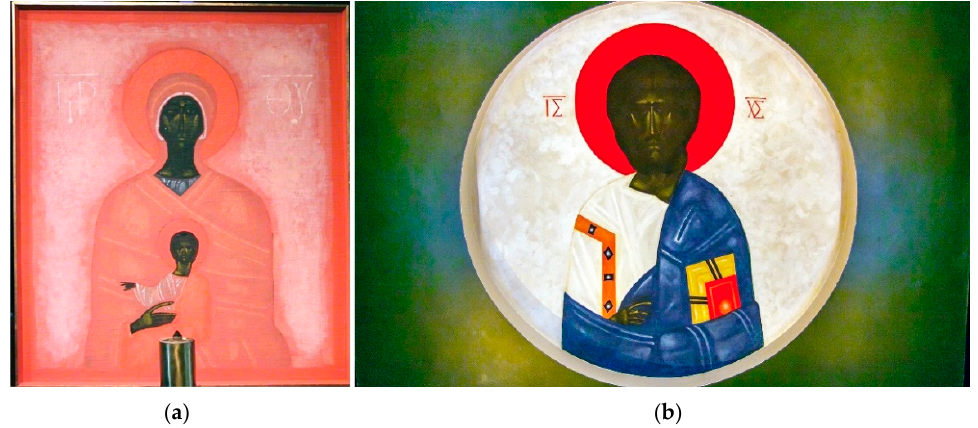
Figure 16. Jerzy Nowosielski, icons in the Church in Bia ł y Bór: ( a ) Theotokos in the iconostasis. ( b ) Pantocrator in the dome. Reproduced with permission. ( b ) Pantocrator in the dome. Reproduced with